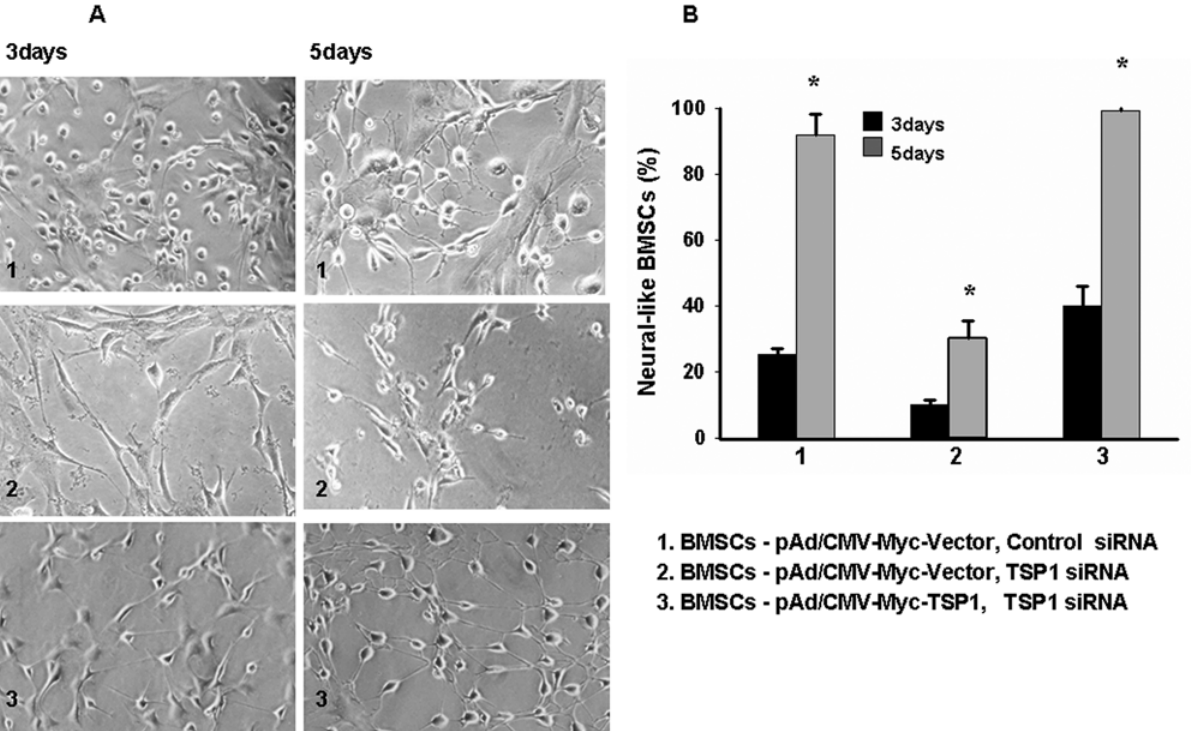
Figure 5. Morphological changes of BMSCs after co-culturing with RGCs when TSP-1 was silenced with siRNA and rescued by infection with a recombinant adenovirus expressing TPS1. 48 hours after the first siRNA transfection, BMSCs and RGCs were co-cultured in a transwell system. A, Neural-like morphological changes (10 6 ) in BMSCs was increased at 3 and 5 days in controls (1). This effect was diminished when TSP-1 was silenced with siRNA (2), but restored in BMSCs infected with a TSP-1-expressing adenovirus (3). B , Bar graph shows the mean and SE of the percentage of neural-like cells in the control, silenced, and rescued BMSCs (p=0.011, p=0.022, p=0.028, respectively). *p-values # 0.05. (10 pictures were taken randomly under a regular microscope from culturing cells at different time points. The average relative percent of neural-like BMSCs come from at least three separate experiments).